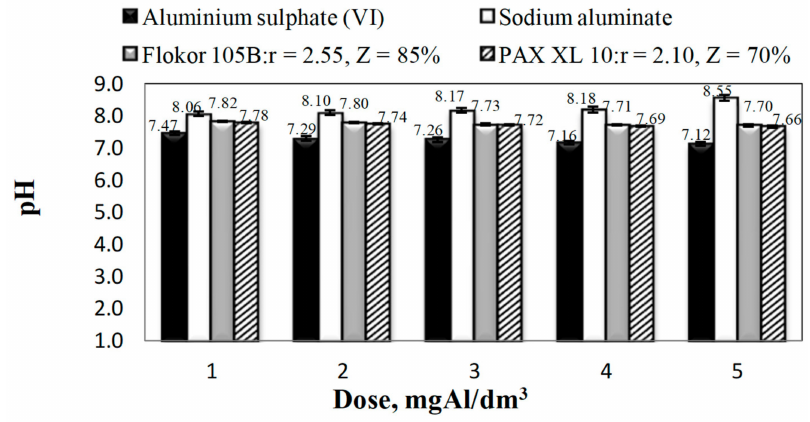
Figure 2. E ff ect of the type and dose of coagulants on the pH in purified water.